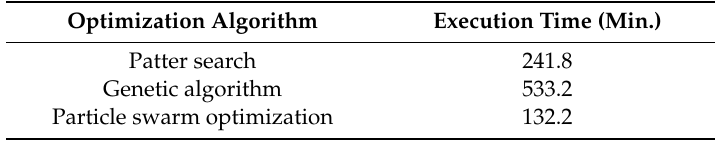
Table 5. Execution time comparison of optimization algorithms for the base case.